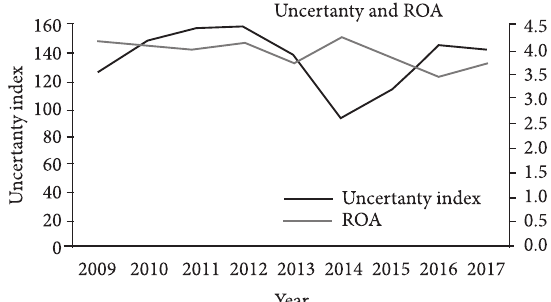
Figure 1. Uncertainty and Returns 1 (Source: composed by the authors according to USDA reports and Economic Policy Uncertainty